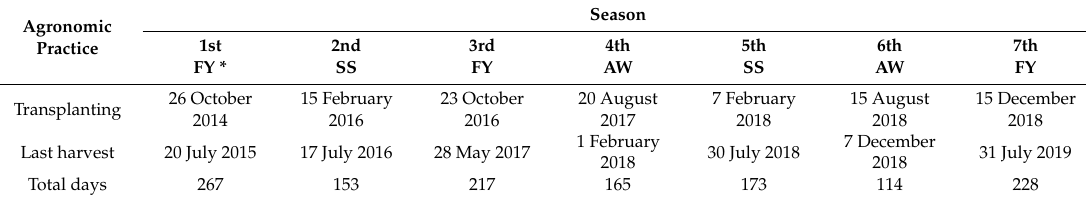
Table 3. Dates of agronomic practices on the seven